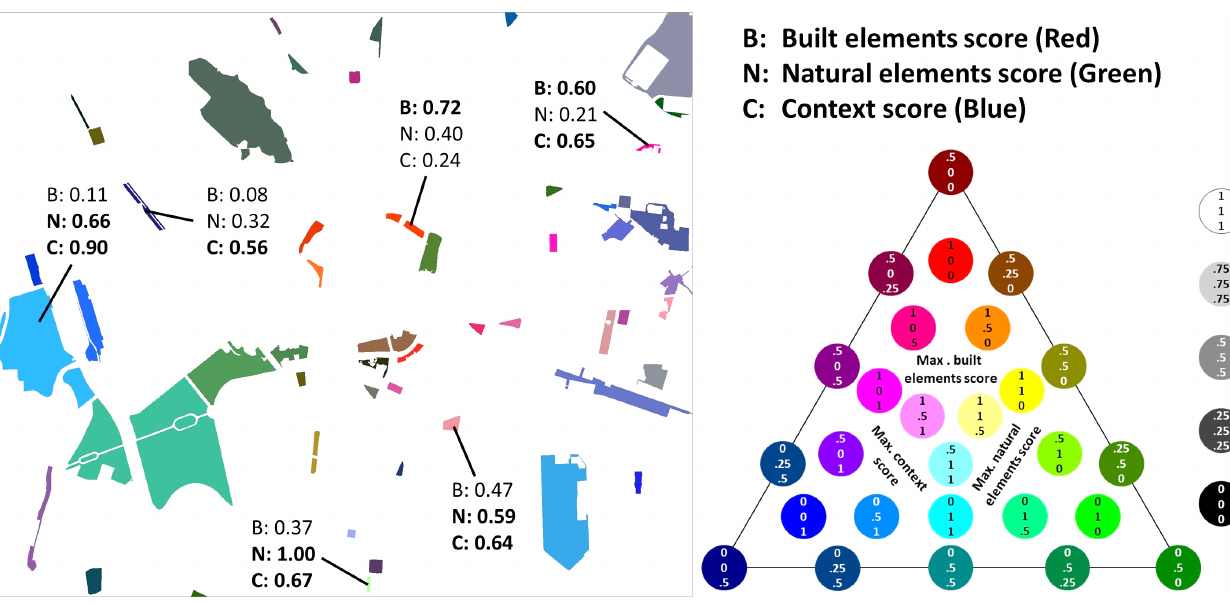
Fig. 7 . Detail of the inner City of Leipzig depicting parks with specific RGB-color composite derived from normalized scores per park quality dimension. Mode of visualization: normalized dimension scores (0 to 1) are transformed to a color space (0-255), with red representing built-elements score, green representing natural-elements score, and blue representing context score. Light shades indicate high, dark colors low index values, e.g., as 0-0-0 would be black (0-0-0 RGB-color mix) and 1-1-1 would be white (255-255-255 RGB-color mix). For full and interactive view of the data, please refer to the online GIS under https://arcg.is/0GXafX or download all results as geodata from Kraemer and Kabisch